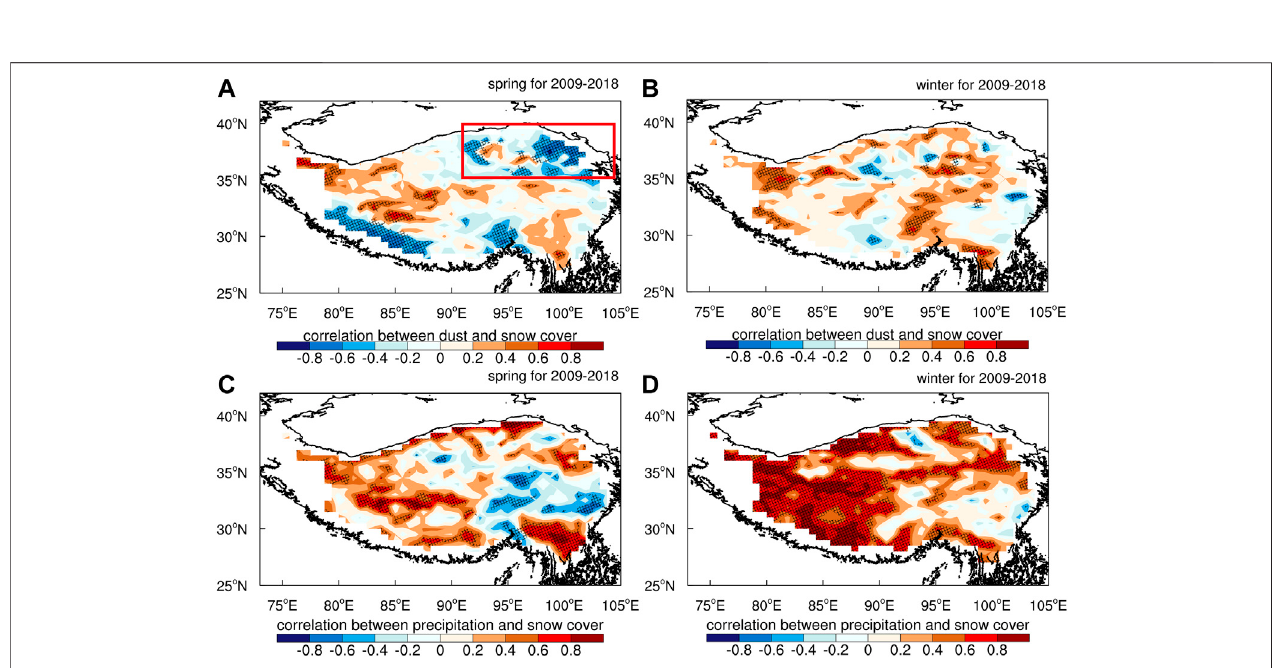
FIGURE 7 | Spatial distributions of correlation between dust concentration (units: mg m − 3 ) and snow cover (units: %) over the TP in (A) MAM and (B) DJF for 2009 – 2018.Spatialdistributionsofcorrelationbetweenprecipitation (units:mm)andsnowcover(units:%)overtheTPin (C) MAMand (D) DJFfor2009 – 2018.Regions passing the 85% signi fi cance level are highlighted by stipple. Signi fi cance is assessed through the t value of the ensemble trend.